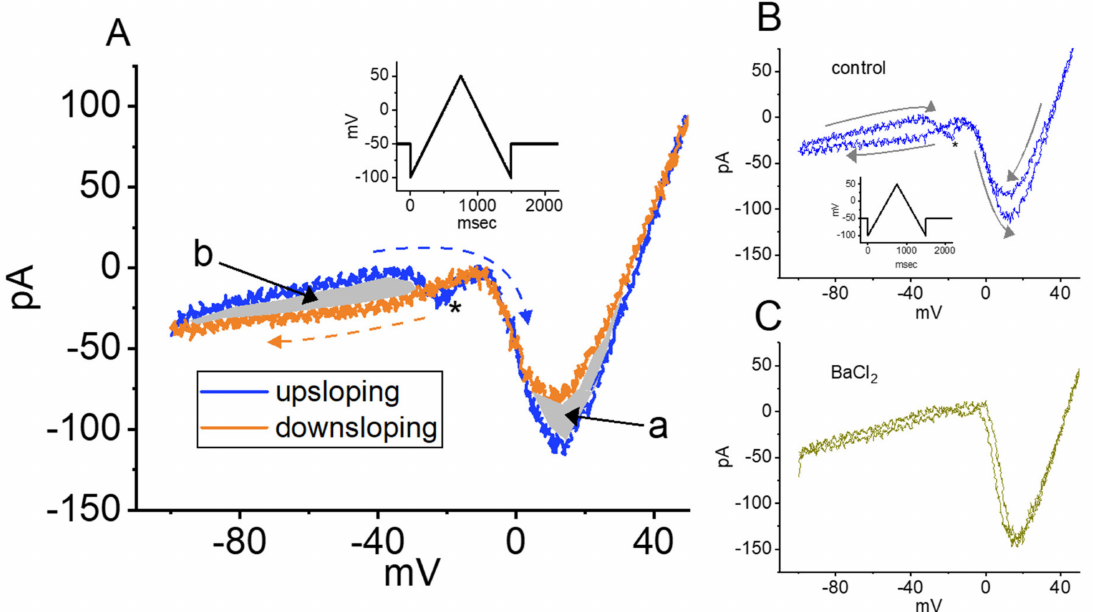
Figure 4. Characterization of voltage-dependent hysteresis (i.e., an instantaneous current–voltage relationship) of I Ca,L identified in GH 3 cells. Cells were bathed in a normal Tyrode’s solution containing 10 mM TEA and 1 µ M TTX, and the electrode was filled with a solution containing Cs + . ( A ) Current traces were evoked by a 1.5 s double ramp voltage (as indicated in the inset). The ascending limb is shown in blue, and the descending one is shown in orange. The arrow denotes the direction of the current trajectory over time, while the asterisk notes the appearance of I Na(P) inhibited by replacement with BaCl 2 . The grey area labeled as a and b, respectively, illustrates the hysteretic loop of I Ca,L (i.e., high- and low-threshold loops). ( B , C ) show the hysteretic loop of the current trace obtained in the control period (i.e., I Ca,L ) and the BaCl 2 substitution (i.e., Ba 2+ inward current [ I Ba ]), respectively. The representative current trace in ( B ) is the control (i.e., ZO was not present), while that in ( C ) was obtained when 2 mM BaCl 2 was substituted for CaCl 2 . It should be noted that the hysteretic strength (i.e., both loops) of I Ca,L elicited by the double ramp pulse (indicated in the inset of ( B )) was diminished as the replacement of CaCl 2 with BaCl 2 was